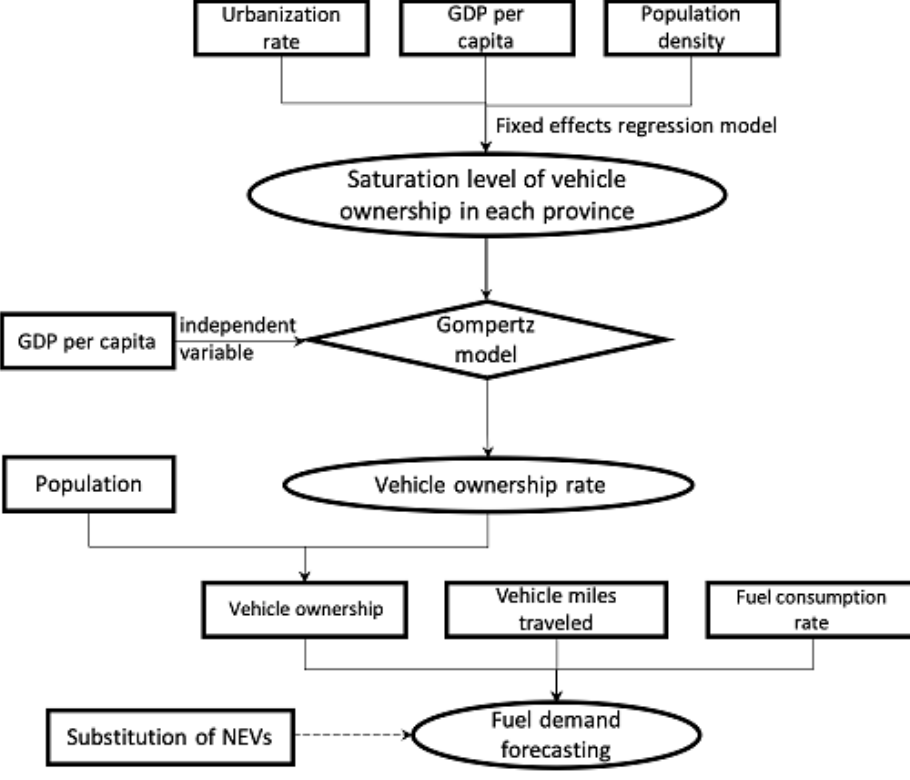
Figure 1. Fuel demand forecasting framework.